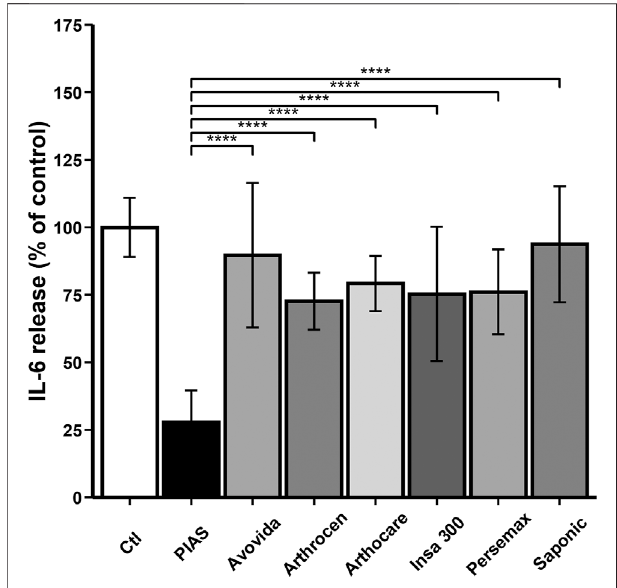
FIGURE 4 | Effect of ASU products tested on total IL-6 production. The chondrocytes were cultured for 12 days either without any ASU (negative control, Ctl) or with 10 µg/ml of either PIASCLEDINE-ExpASU ® (PIAS) or one of the six other nutraceutical products being evaluated in comparison, namely, Avovida, Arthrocen, Arthocare, Insaponi fi able 300 (Insa 300), Persemax, or Saponic. Each product has been tested on six independent cultures. Each culture condition was performed in triplicates. The results are expressed as the percent control and represented by the mean ± SD. **** p < 0.0001 versus PIASCLEDINE-ExpASU ®